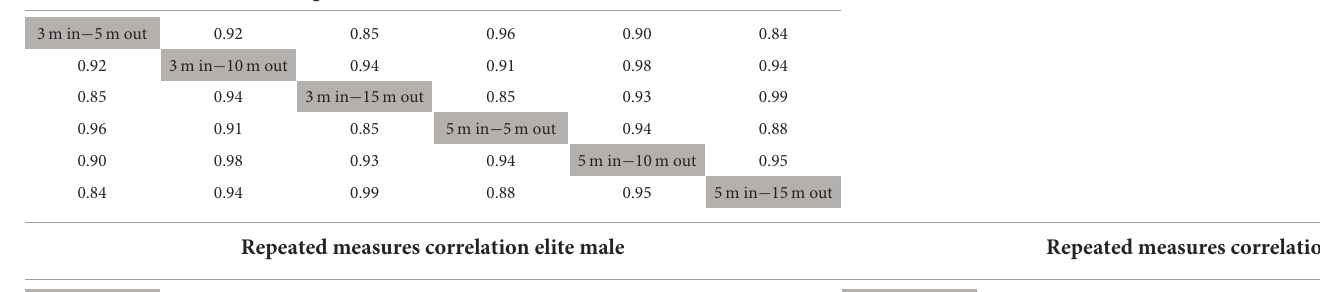
TABLE 3 The repeated measures correlation coefficient matrix between all possible combinations of performance measures for the entire data set and the elite male and female, and sub-elite male and female swimmers separately. Repeated measures